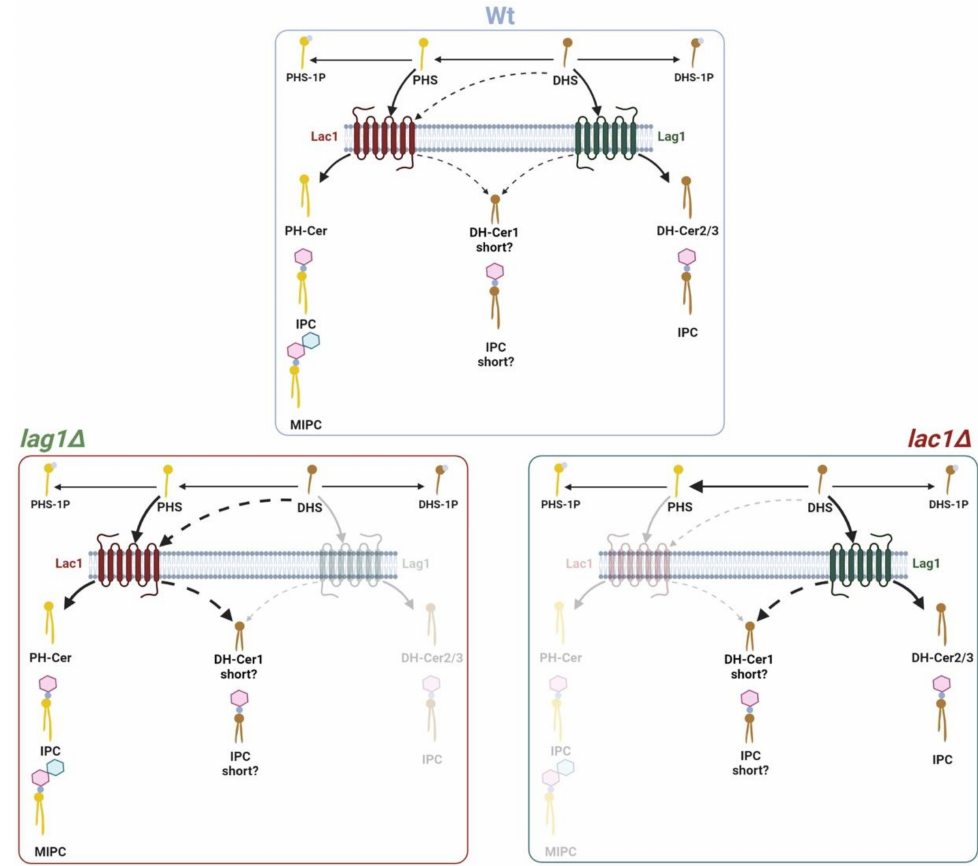
Figure 6. Model that explains ceramide and complex sphingolipid synthesis in wild-type, lac1 ∆ and lag1 ∆ cells in fission yeast. PHS, phytosphingosine; PHS-1P, phytosphingosine-1-phosphate; DHS, dihydrosphingosine; DHS-1P, dihydrosphingosine-1-phosphate IPC, inositolphosphorylceramide; MIPC, mannosylinositolphosphorylceramide; PH-Cer, DH-Cer1, DH-Cer2, DH-Cer3, different ce- ramide species. Figure created with